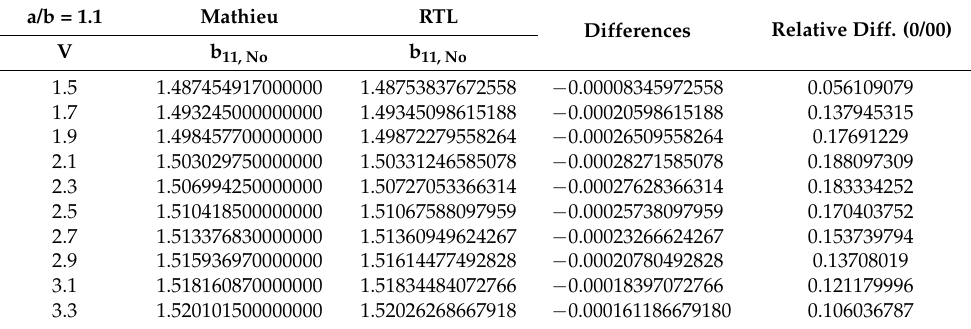
Figure 5. Elliptic fiber with three indicative elliptic thin layers. Inside the ellipse r < b ( n = n 1 ), outside the ellipse r > a ( n = n 2 ) and partly outside b < r < a ( n 1 > n > n 2 ). Table 1. Comparison of ellipse for the fundamental modes.